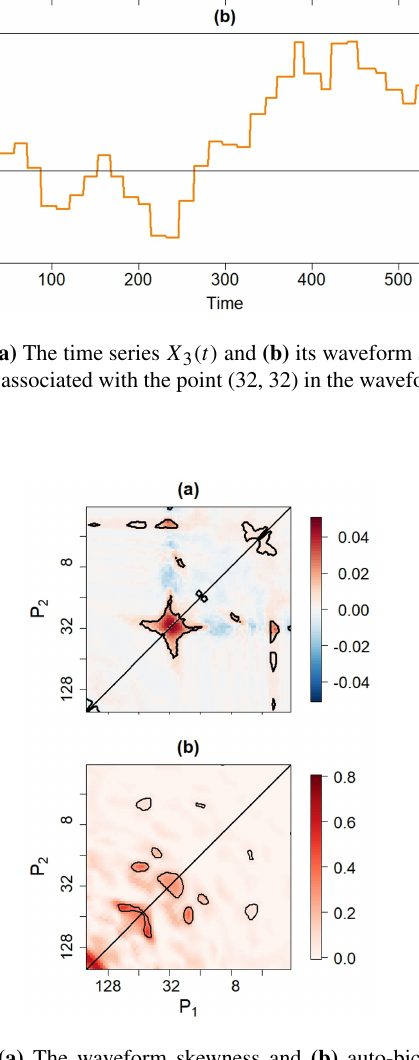
Figure 4. (a) The waveform skewness and (b) auto-bicoherence spectra associated with X 3 (t) . Contours enclose regions of 5% sta- tistical